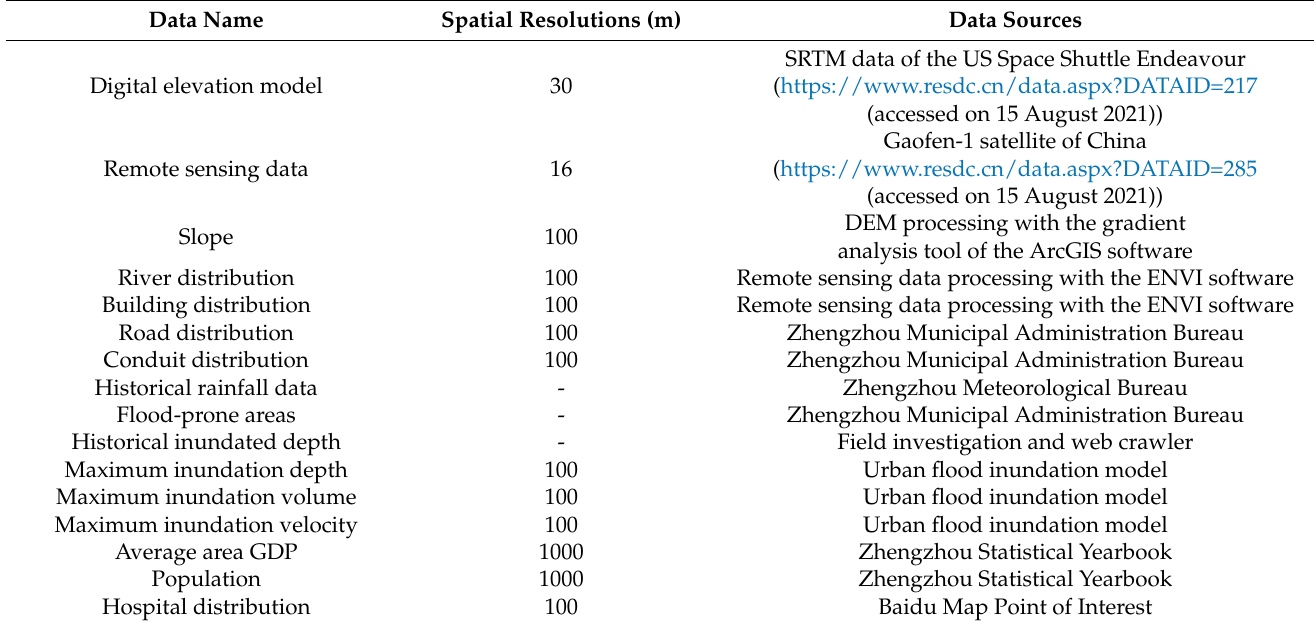
Table 1. Statistical table of data.